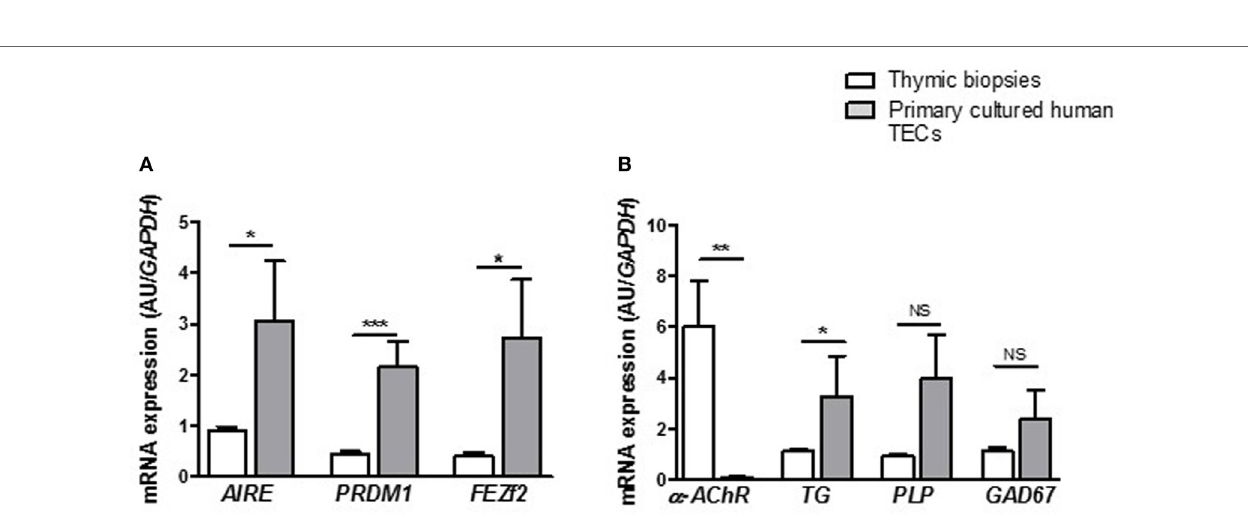
FIgURe 2 | Primary cultured human thymic cells display medulla thymic epithelial cell features. Representative pictures of a primary cultured human thymic epithelial cells (TECs) (day 7) (A–C) and human thymus (d–F) co-labeled with an anti-Claudin 4 antibody (red), anti-keratin 5, and 14 antibodies (green). Representative pictures of primary cultured human TECs (g–I) and human thymus (J–L) co-labeled with an Ulex europaeus agglutinin I lectin (UEA) (red), anti-keratin 5 and 14 antibodies (green). The percentage of positive cells in primary cultured human TECs represented the number of KERATIN 5/14, ClAUDIN 4, or UEA positive cells versus the total cell number (M) . For thymic sections, the surface of KERATIN 5/14 or ClAUDIN 4 positive areas was measured and compared with the thymic medulla. Images were acquired with a Zeiss Axio Observer Z1 Inverted Microscope using 20 × magnification. The counting was done as previously described in Dragin et al. (50). ImageJ software was used to display the digital pictures and to count manually the labeled cells. Graph bar represents the results obtained with four different human biopsies and primary cultured human TECs. The non-parametric Mann–Whitney test was used for statistical